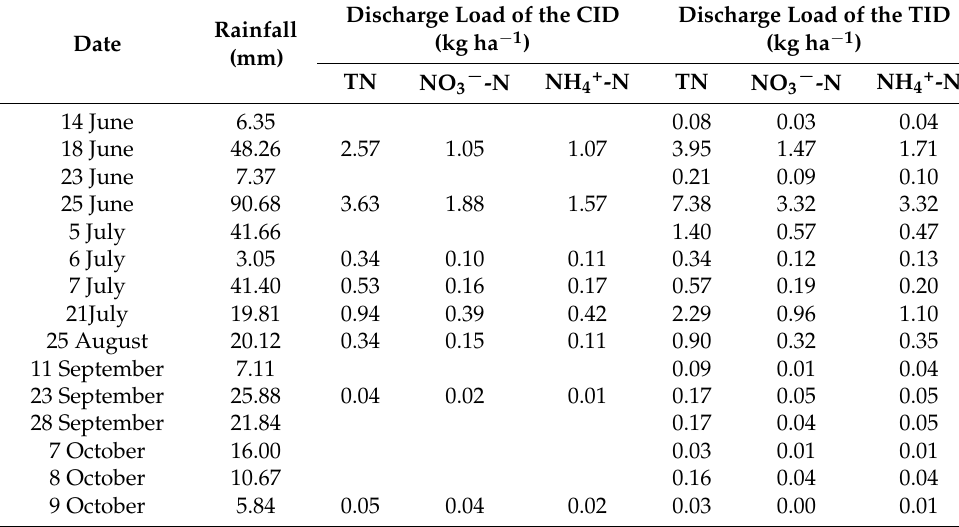
Figure 8. Regression analysis of rainfall and discharge load using daily data. Table 4. Rainfall runoff losses of various N forms from the CID and TID modes.